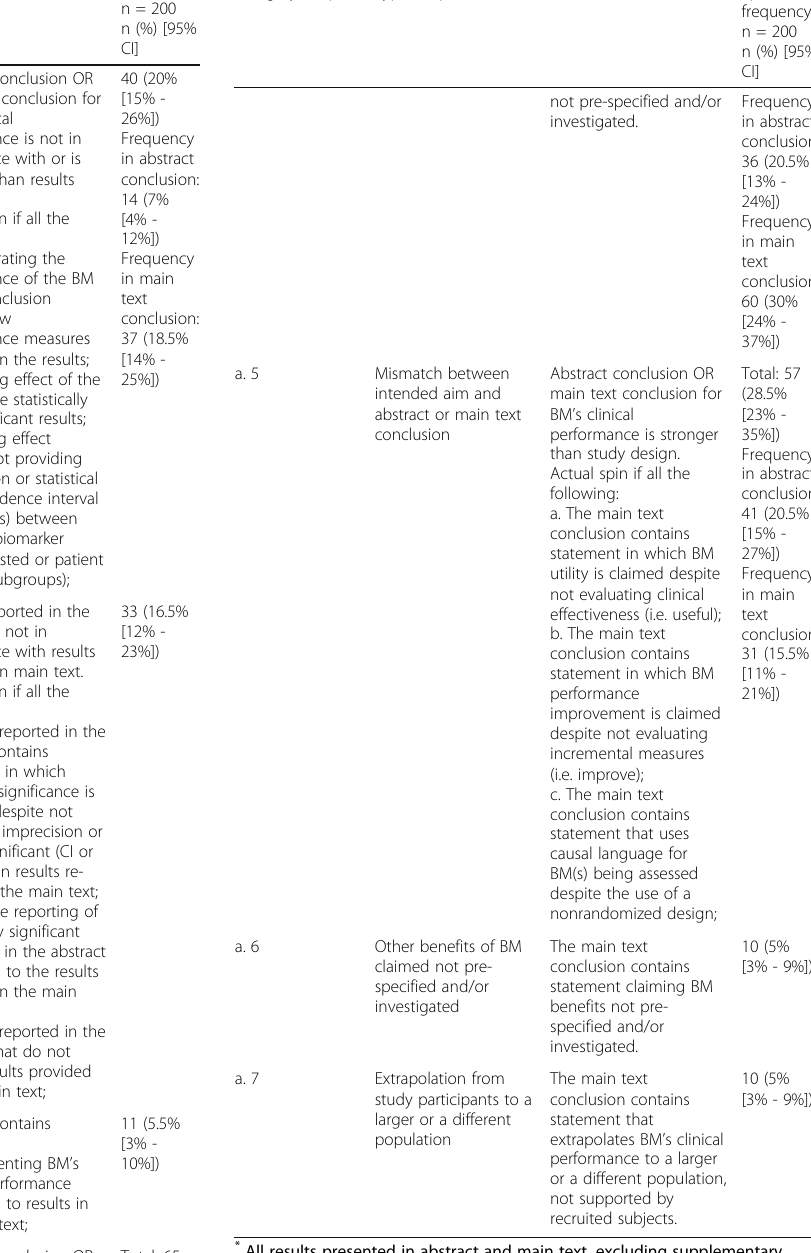
Table 1 (abstract P25). Actual forms of spin in clinical studies evaluating performance of biomarkers in ovarian cancer with examples Category of spin Type of spin